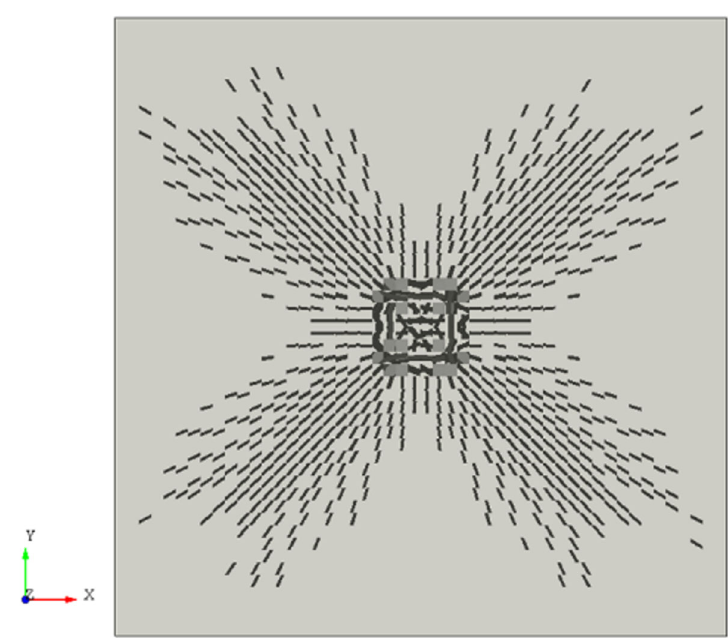
Fig. 13 Cracked slab: standard values for concrete and E def 33.86